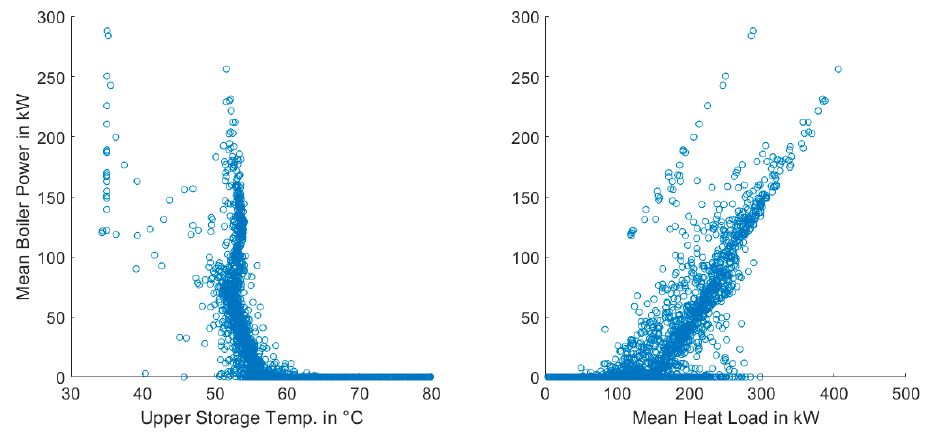
Figure 8. Mean boiler power against top storage temperature ( left ) and heat load ( right ).